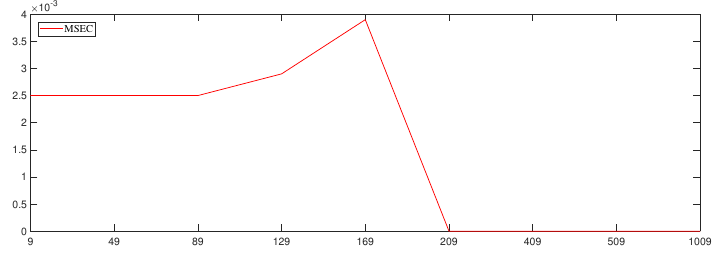
Figure 7. Folding line plot of the mean square error for a variance of